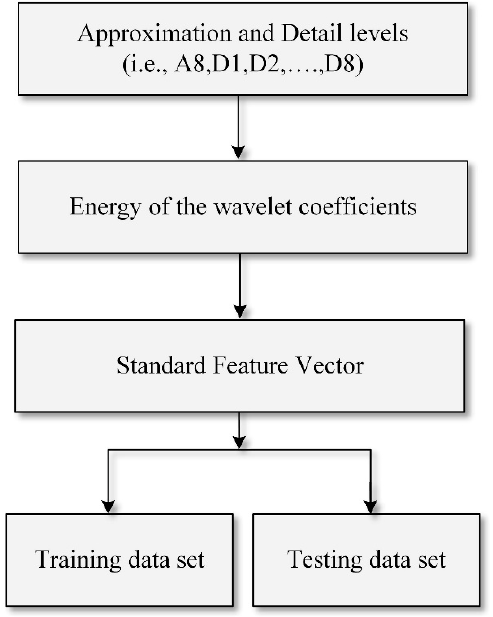
Figure 11. Flow chart for the development of the feature vector.